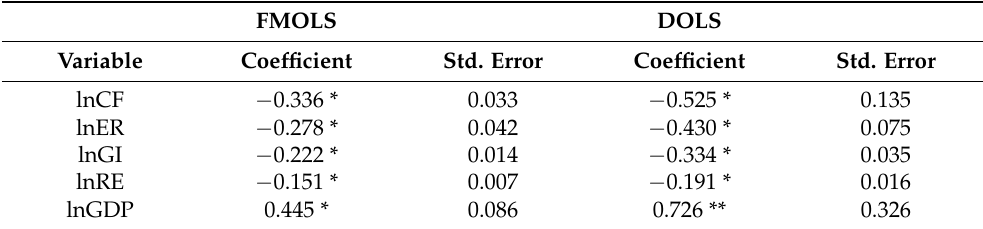
Table 9. FMOLS and DOLS test results (Robustness check). FMOLS DOLS Variable Coefficient Std. Error